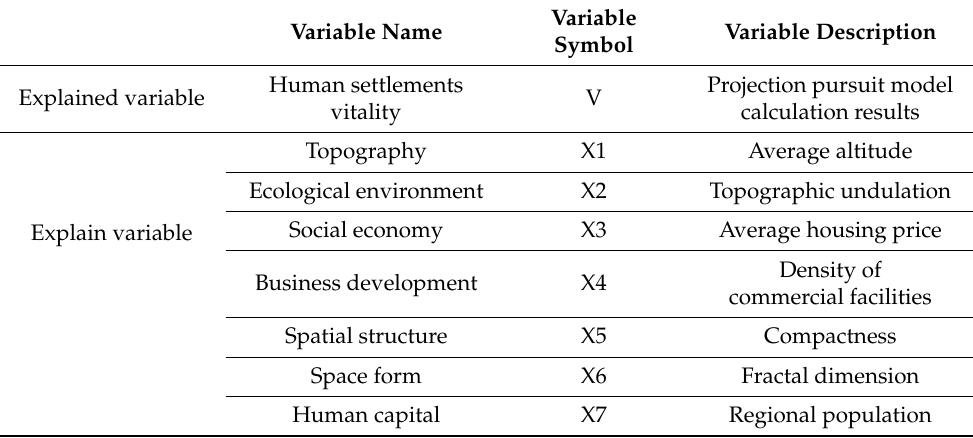
Table 3. Factors affecting the vitality of urban human